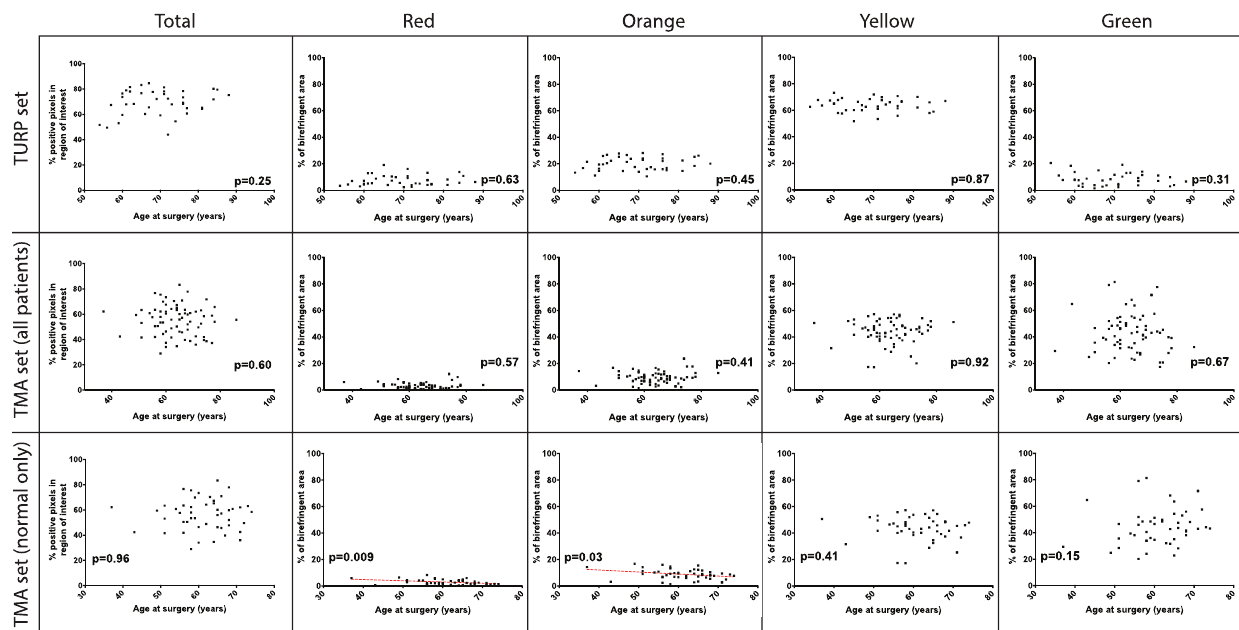
Figure 5. Association of patient age with Picrosirius red collagen content in prostate tissues. The association of Picrosirius red collagen content and patient age at time of surgery was investigated in cohorts of BPH only tissues (TURP set), a combination of BPH and normal prostate tissue (TMA set [all patients]), and a subset of only normal prostate tissue (TMA set [normal only]). Total collagen content and the distribution of birefringent colors were not associated with age in the TURP set or combination TMA set (all patients) of tissues (p . 0.05). Total collagen content was not associated with age in the TMA subset of normal only patients (p=0.96), but a significant negative correlation between age and birefringent color proportions was observed for red (p=0.009) and orange (p=0.03) birefringence. No association was found between age and yellow (p=0.41) or green (p=0.15) birefringence in the normal only subset of prostate tissues.